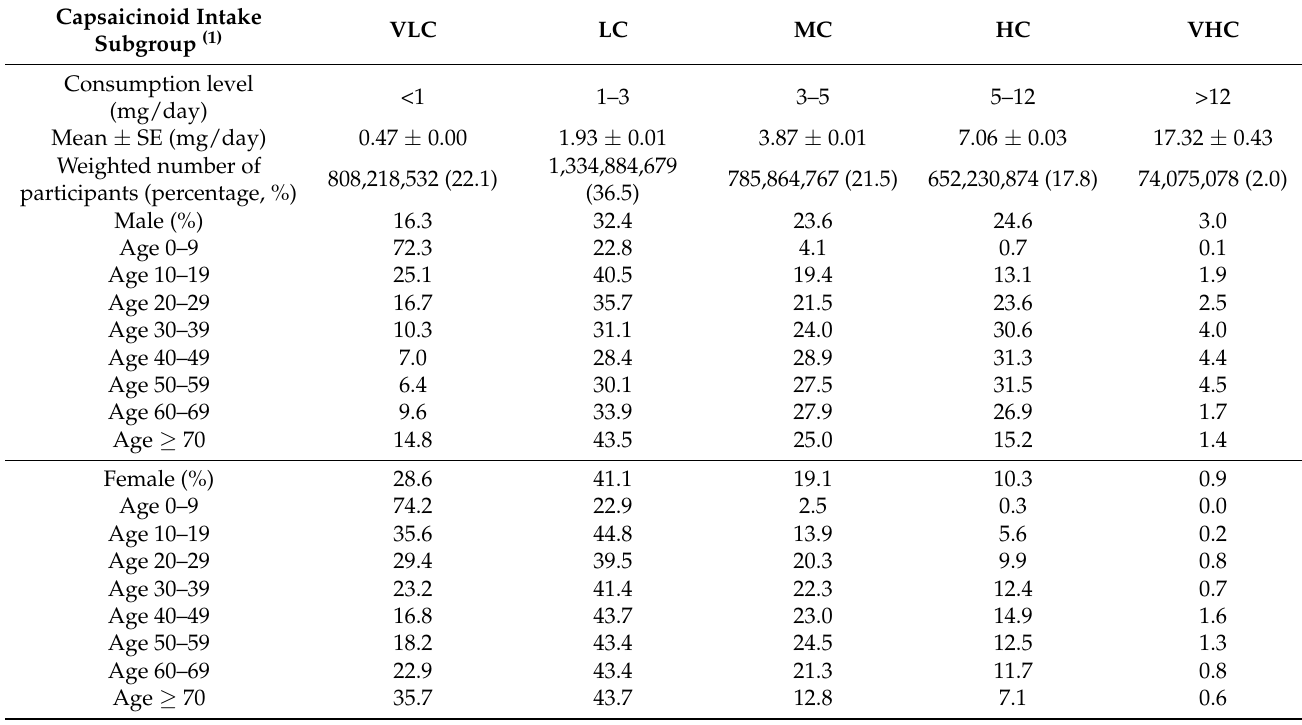
Table 2. Percentage (%) of participants in the five subgroups divided by their capsaicinoid consumption levels in different age groups in males and females. Capsaicinoid